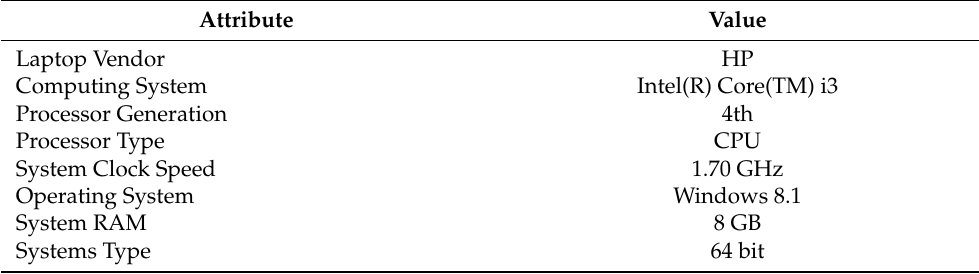
Table 4. System configurations for